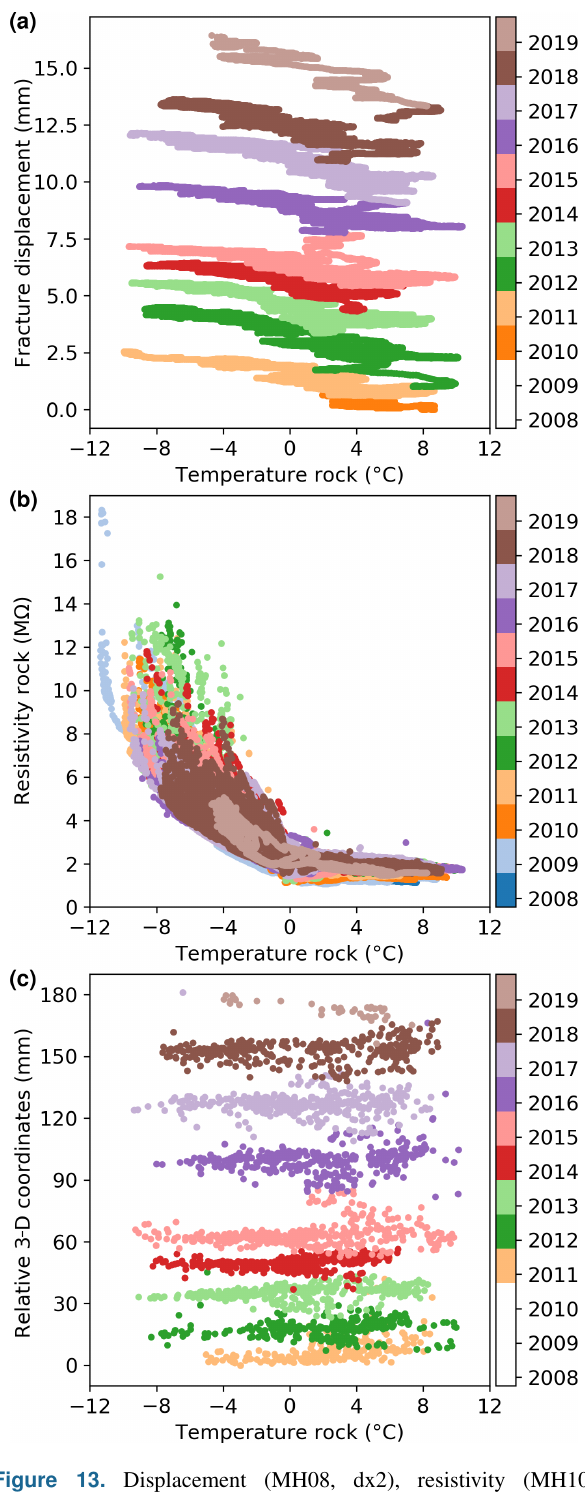
Figure 13. Displacement (MH08, dx2), resistivity (MH10, 85cm) and relative 3-D coordinates derived from L1/L2 GNSS (MH42/HOGR) plotted against rock temperature (85cm) at posi- tion MH10.